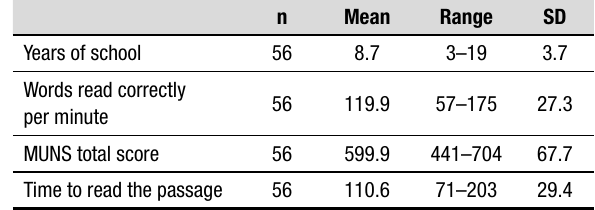
Table 2. Means and standard deviations of the variables under analysis.